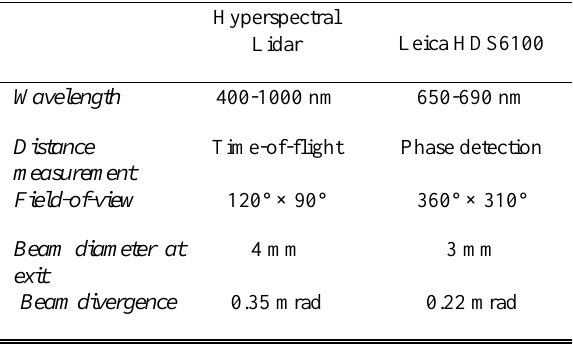
Table 1. The scanner